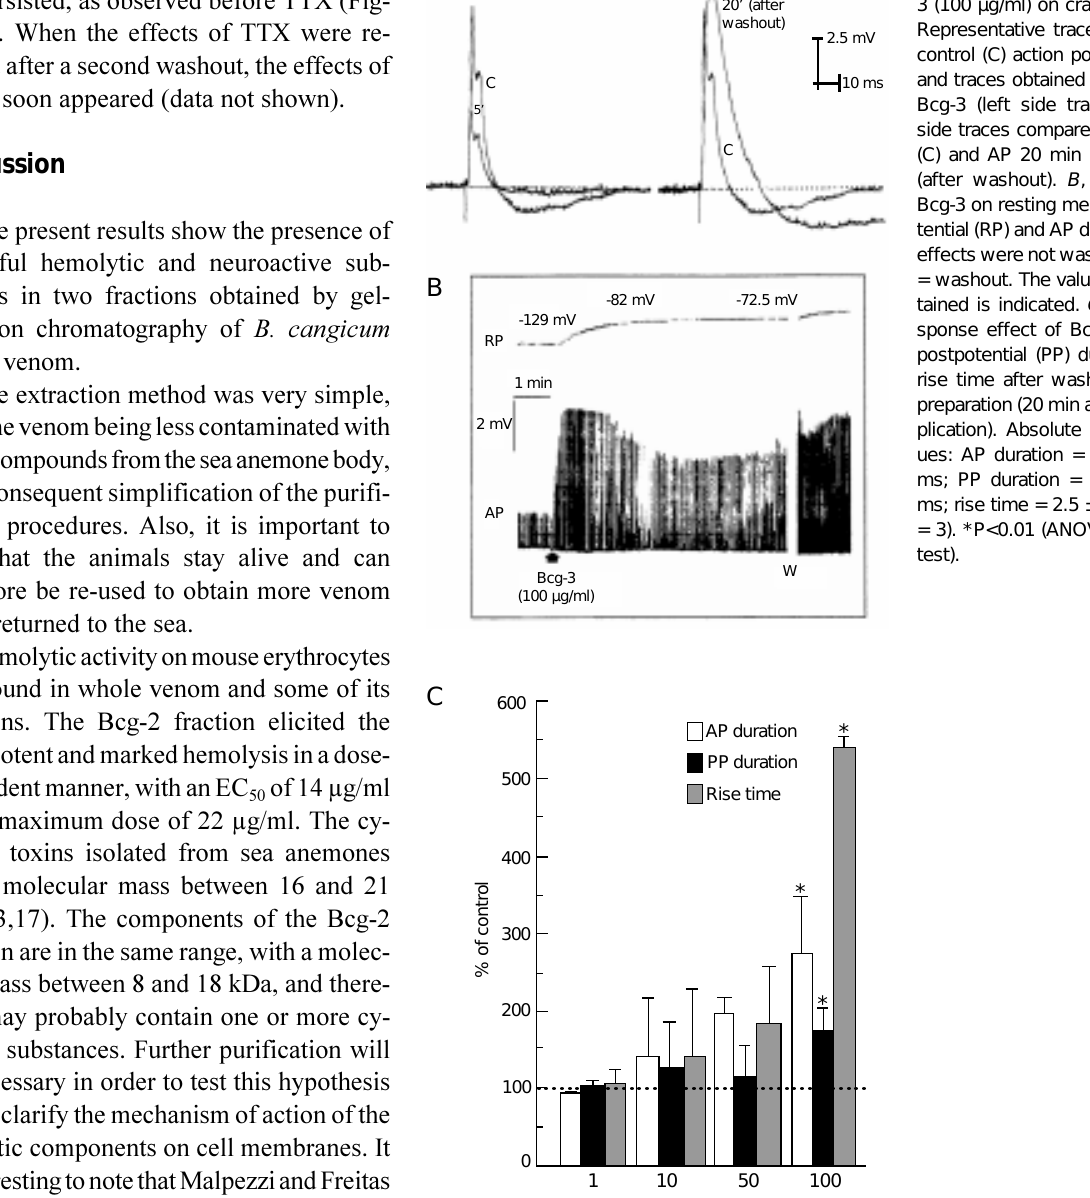
Figure 3. Effects of fraction Bcg- 3 (100 µg/ml) on crab nerve. A , Representative traces showing control (C) action potential (AP) and traces obtained 5 min after Bcg-3 (left side traces). Right side traces compare control AP (C) and AP 20 min after Bcg-3 (after washout). B , Effects of Bcg-3 on resting membrane po- tential (RP) and AP duration; the effects were not washed out. W = washout. The value of RP ob- tained is indicated. C , Dose-re- sponse effect of Bcg-3 on AP, postpotential (PP) duration and rise time after washout of the preparation (20 min after the ap- plication). Absolute control val- ues: AP duration = 14.8 ±